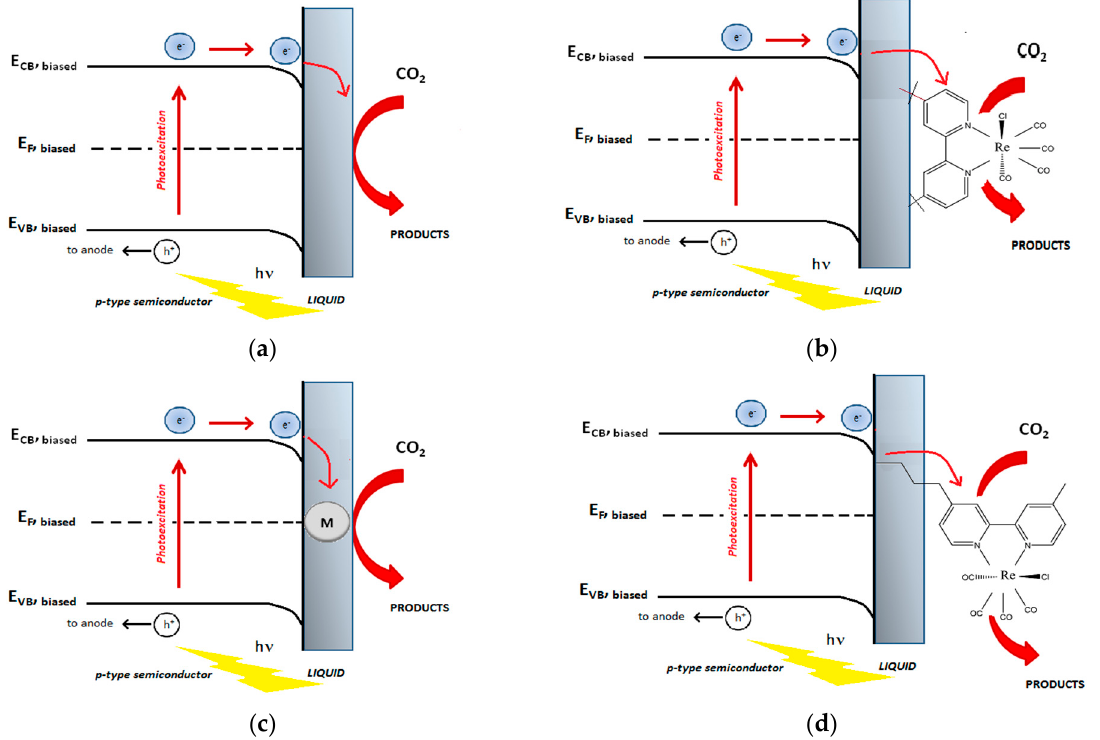
Figure 20. Schematic representation of four possible mechanisms of light ‐ assisted CO 2 reduction on a p ‐ type semiconducting photocathode: ( a ) heterogeneous photoelectrocatalysis on a semiconductor electrode; ( b ) homogeneous catalysis through a molecular catalyst in the electrolyte; ( c ) heterogeneous catalysis on a metal ‐ decorated semiconductor electrode; ( d) heterogeneous catalysis via a molecular catalyst anchored on the semiconductor electrode. The p ‐ type semiconductor represents the light ‐ absorbing species. Adapted from reference [21].